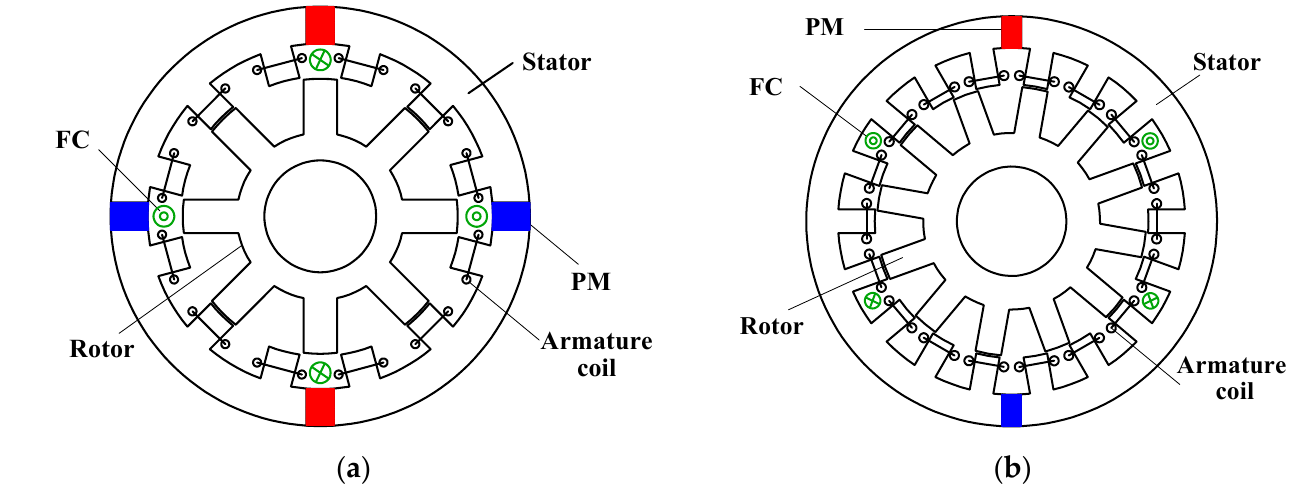
Figure 9. Cross section of a parallel stator ‐ excited HE machine with bipolar flux ( a ) with iron bridge for parallel coupling [45] and ( b ) without iron bridge for series coupling [47].